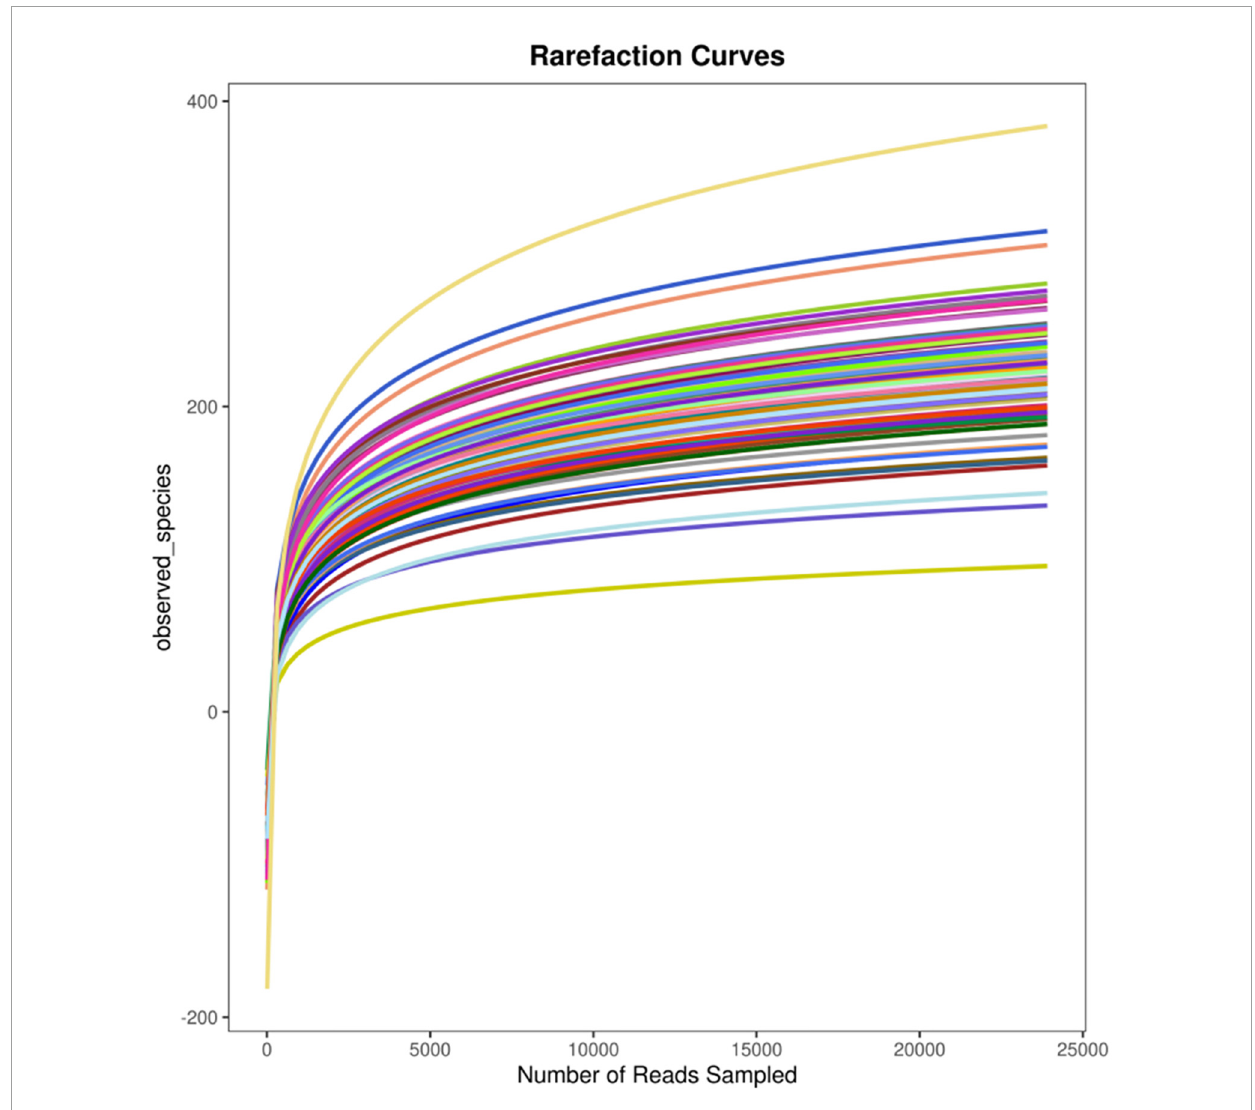
FIGURE2 Simpson rarefaction curve.